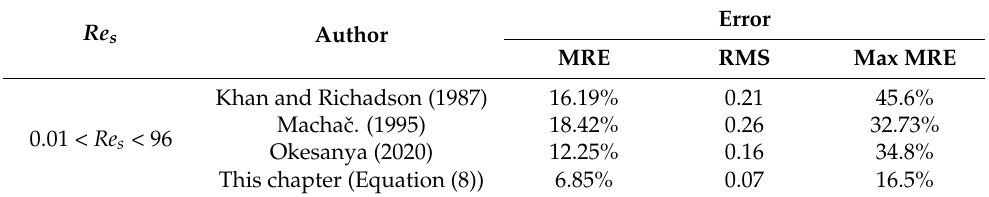
Table 4. Error Statistics of Drag Coefficient of Spherical Particles Settlement in Herschel–Bulkley Fluid.